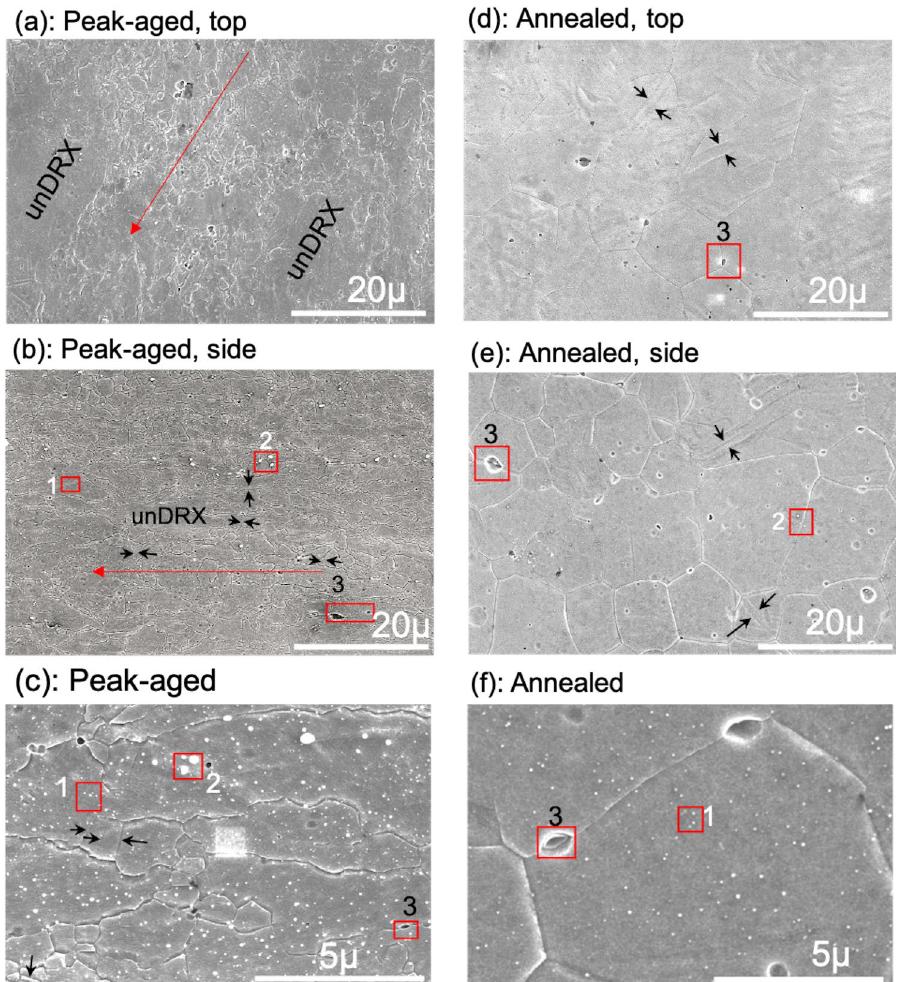
Figure 1. SEM images showing the grain morphology and precipitates for the ( a – c ) peak-aged material: ( a ) top view; ( b ) side view; and ( c ) higher magnification image to further show the submicron grains containing precipitates and twins. For the annealed material: ( d ) top view, ( e ) side view, and ( f ) higher magnification image again to show the precipitates. The red arrow indicates the rolling direction and the black arrows the twins. Labels 1, 2 and 3 in these images point respectively to the alpha-Mn precipitates, the Ca 2 Mg 6 Zn 3 particles, and the Mg 2 Ca particles, which have been identified by the EDS scans in Figs. 5 and